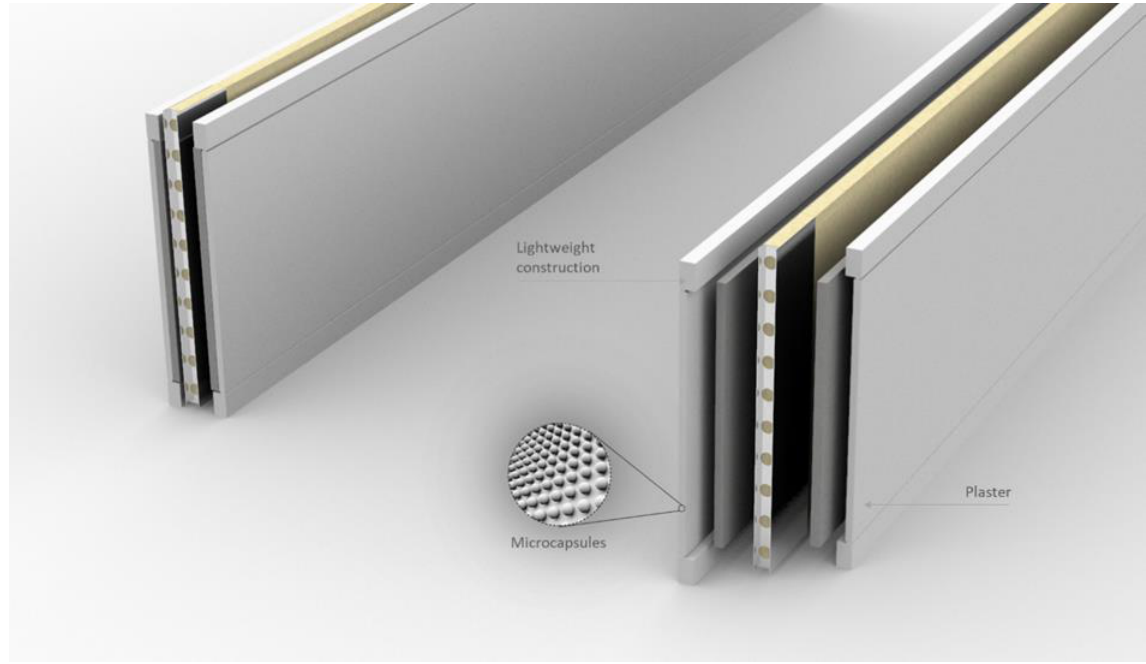
Figure 18. PCM usage as interior plaster on hollow building blocks.